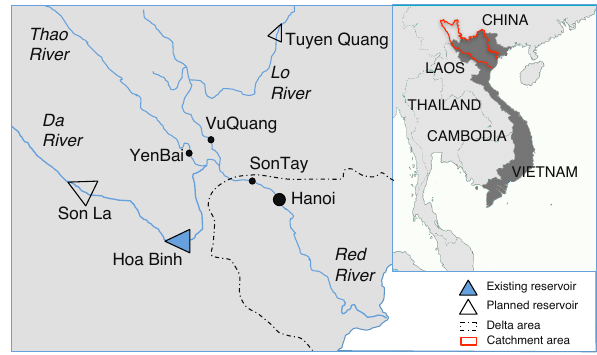
Fig. 1. The Red River Basin in Northern